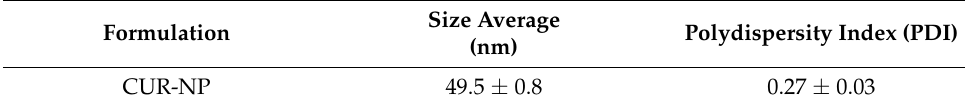
Table 1. Physical characteristics of